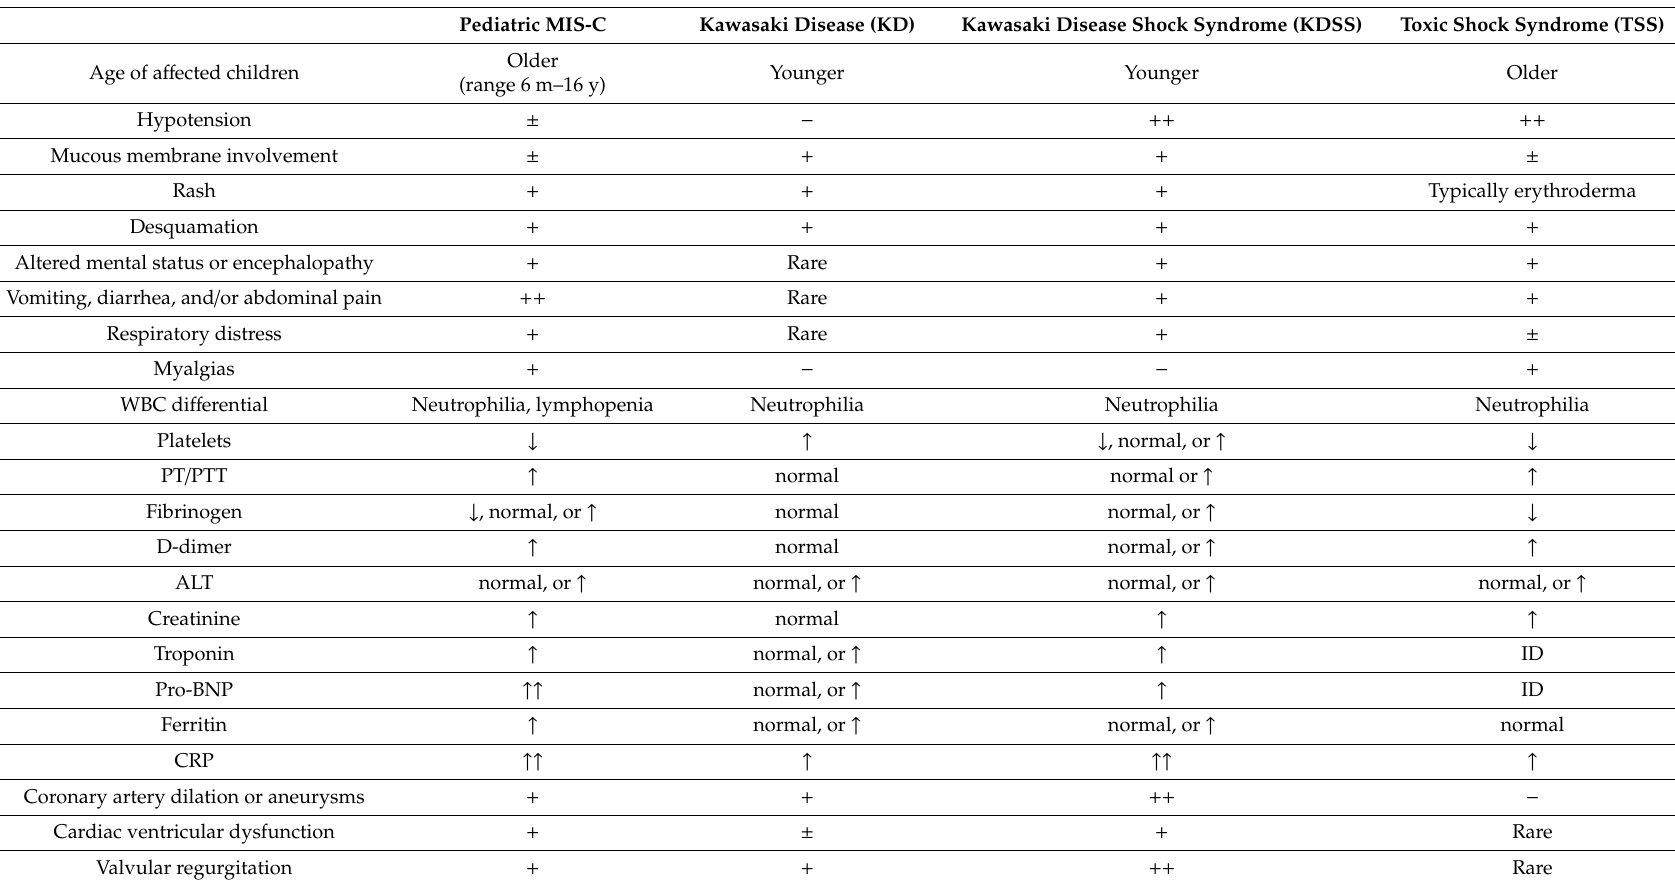
Table 1. Comparison of clinical and laboratory features of MIS-C with KD, KDSS, and